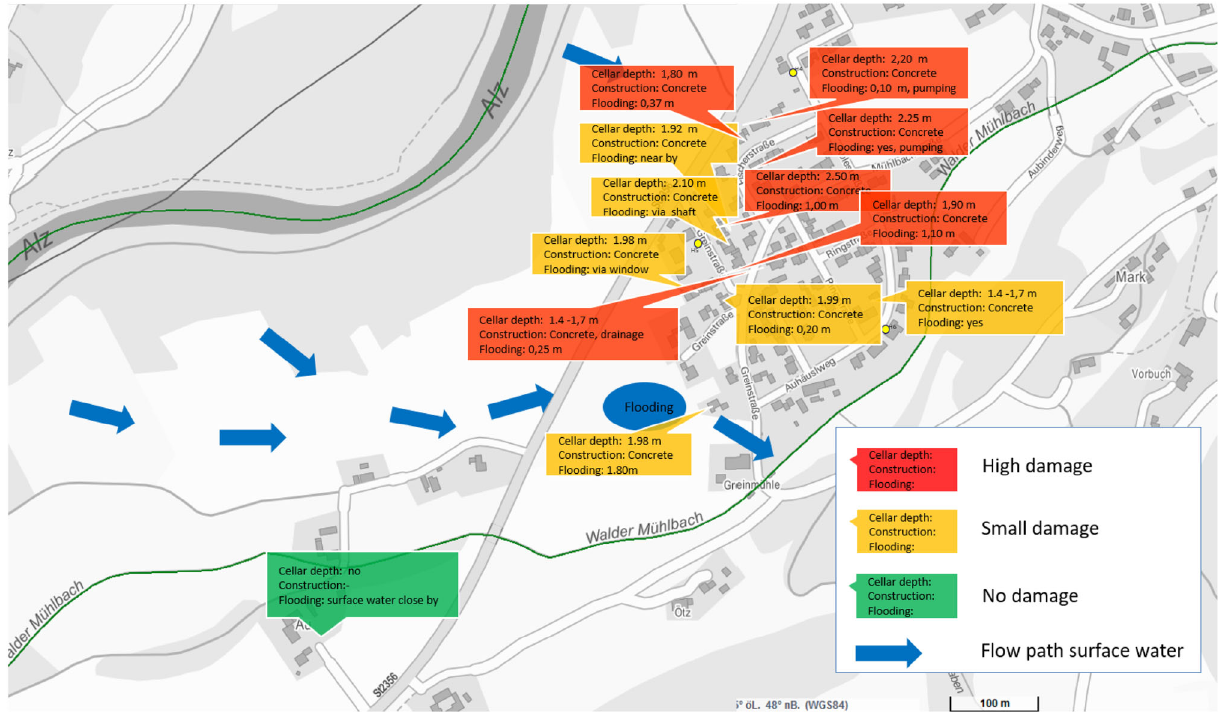
Fig. 8 Analysis of the Hirten questionnaire data ( n = 100) of June 2013 flood